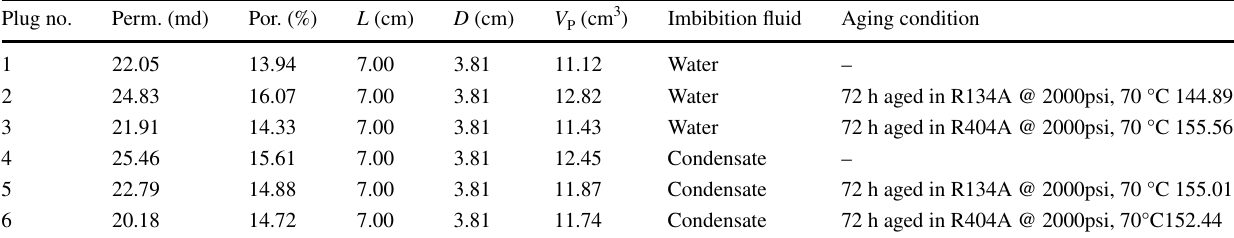
Fig. 11 The curves of the imbibition experiment results at 70 °C and atmospheric